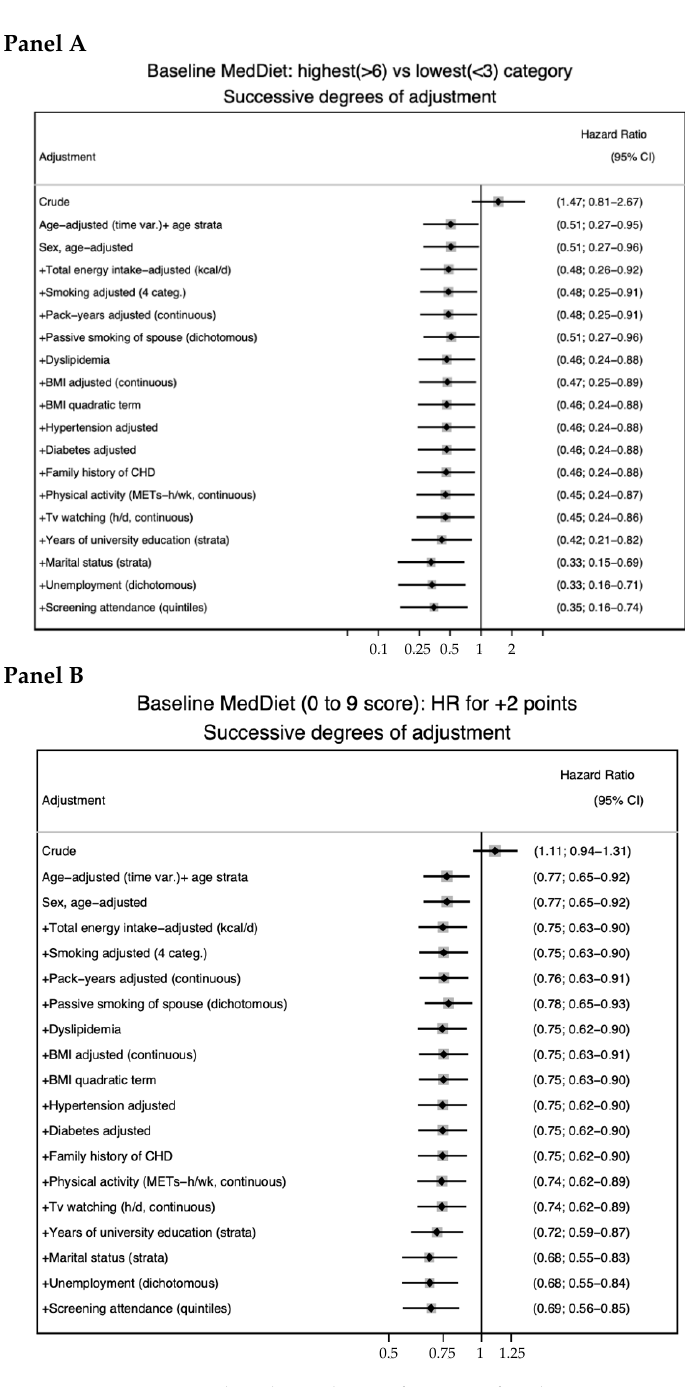
Figure 2. Progressively adjusted HRs for CVD for the comparison between extreme categories ( Panel A ) or associated with 2 additional points in the MDS index ( Panel B ), adding one additional confounder at a time.